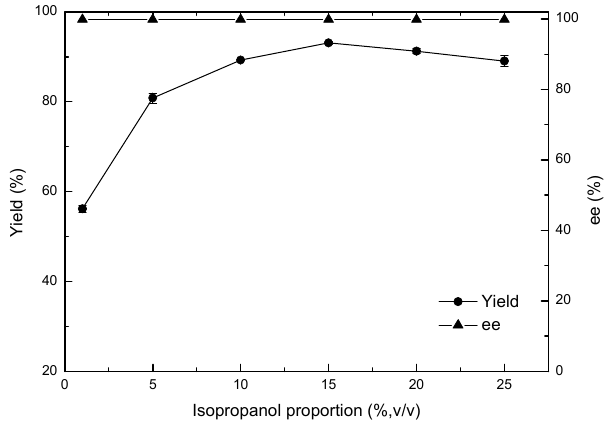
Figure 4. Effect of isopropanol proportion in reaction system on the asymmetric reduction of 4-(trifluoromethyl)acetophenone.